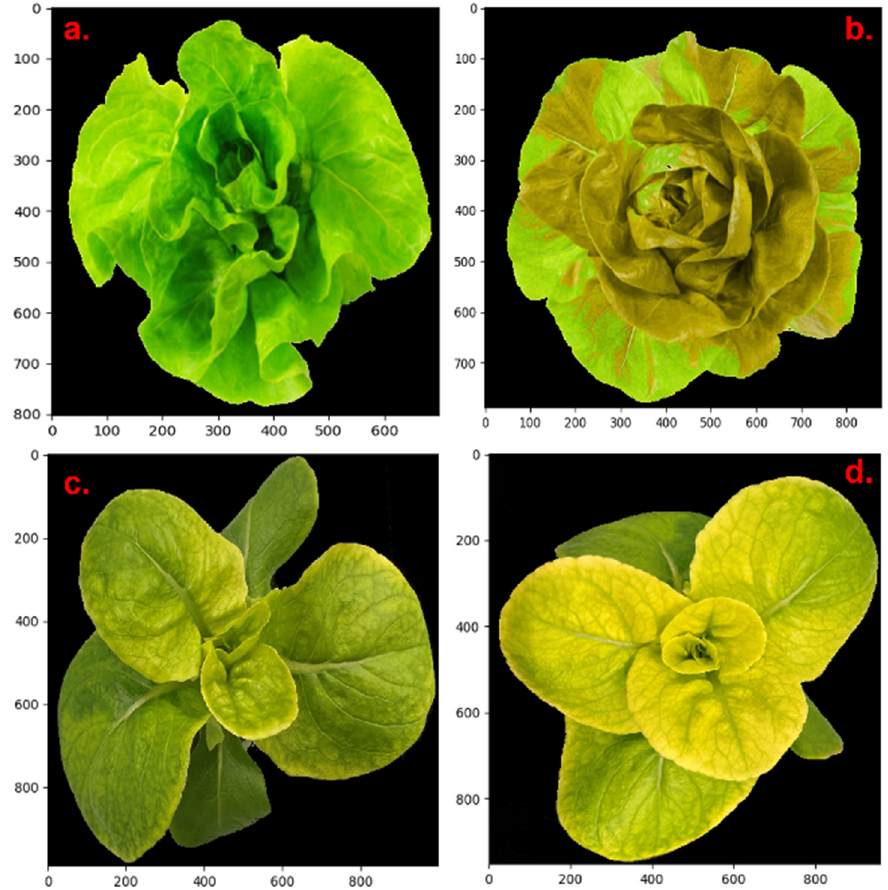
Figure 7. Example of segmented images (( a , c ): segmented green lettuce; ( b , d ): segmented altered yellowed lettuce).